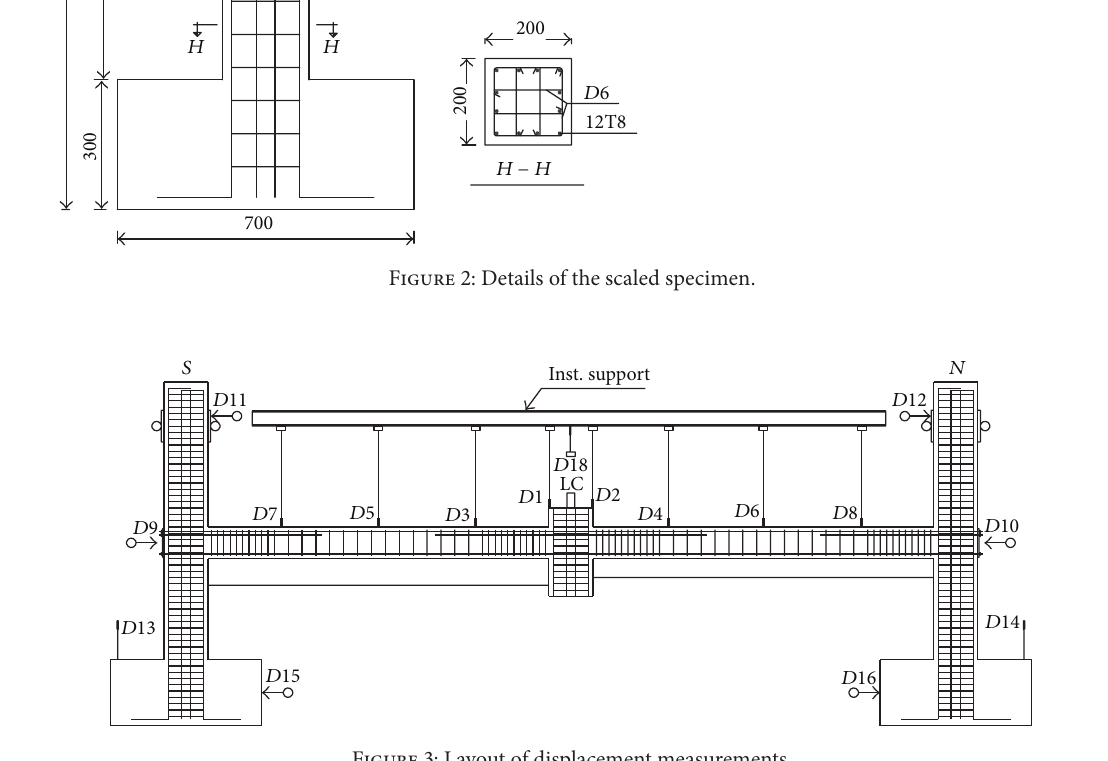
Figure 3: Layout of displacement